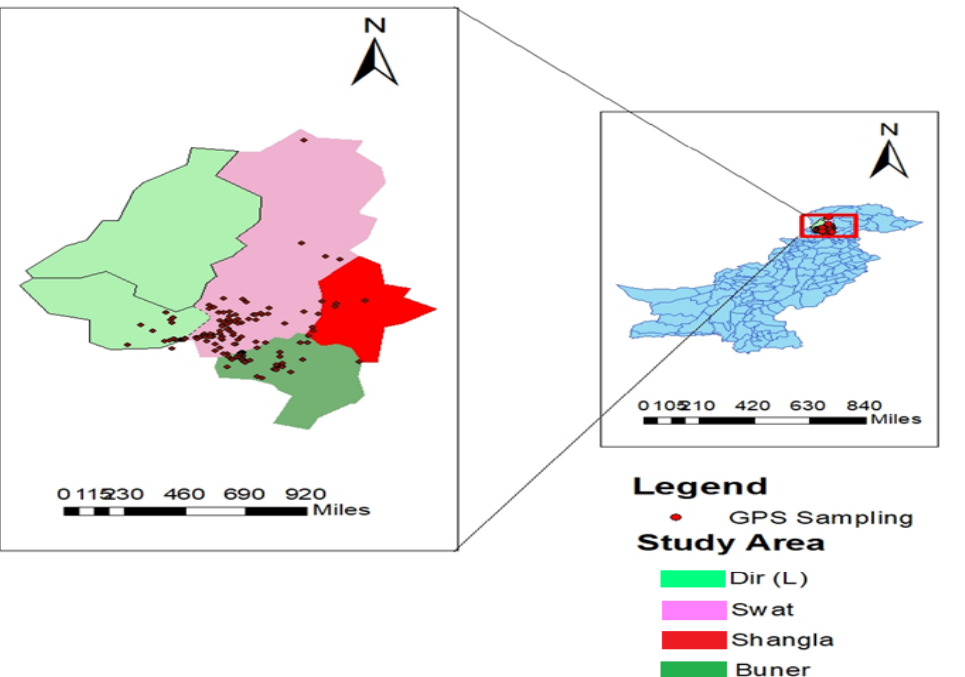
Figure 1. Map of the study area highlighting points of genotypes collection within Malakand division KP, Pakistan.